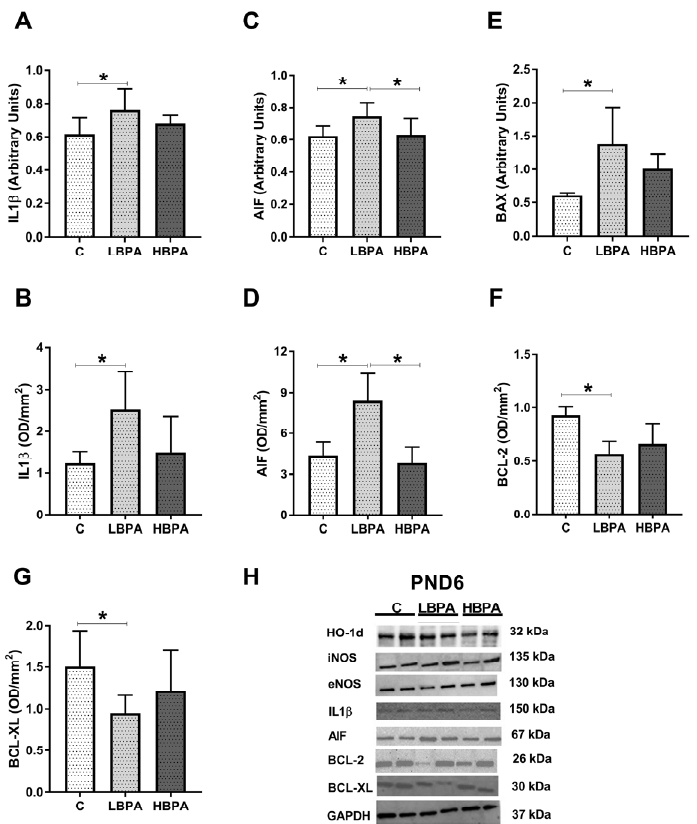
Figure 9. Effects of perinatal exposure to BPA on inflammatory mediator and apoptosis markers in livers from female PND6 offspring. ( A , B ) mRNA and protein expressions of IL1 β (interleukin-1- β ). ( C , D ); mRNA and protein expression of AIF (apoptosis-inducing factor). ( E ) mRNA of BAX (Bcl-2-associated X protein). ( F , G ) Protein expressions of BCL-2 (B-cell lymphoma) and BCL-XL (B-cell lymphoma-extra large). ( H ) Representative images of the Western blot results of the different proteins studied. Data represent mean ± SD. For mRNA, n = 12 control PND6 offspring; n = 12 LBPA PND6 offspring; n = 12 HBPA PND6 offspring (three replicates for each gene). For protein, n = 5 rats per experimental group. Statistical significance was determined by one-way ANOVA. * p < 0.05.